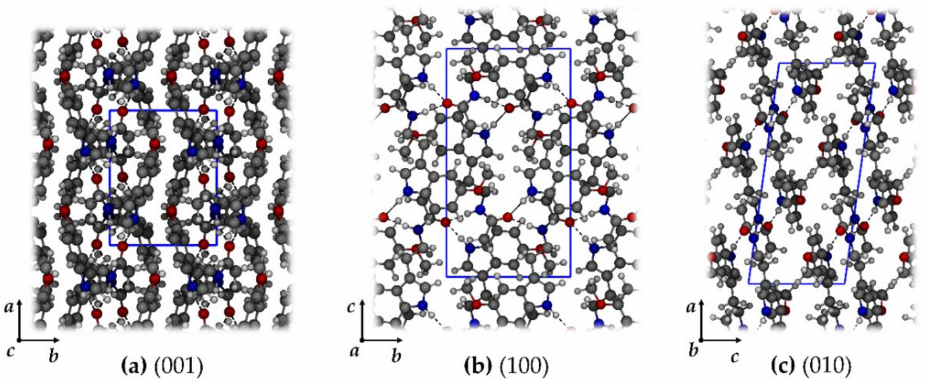
Figure 4. ( a – c ) View from (001), (100), (010) crystallographic plane respectively. PBEh-3c optimized structure of the melatonin crystal. Bond distances are in Å. Atom colors: H white, C grey, N blue, O red. Unit cell in